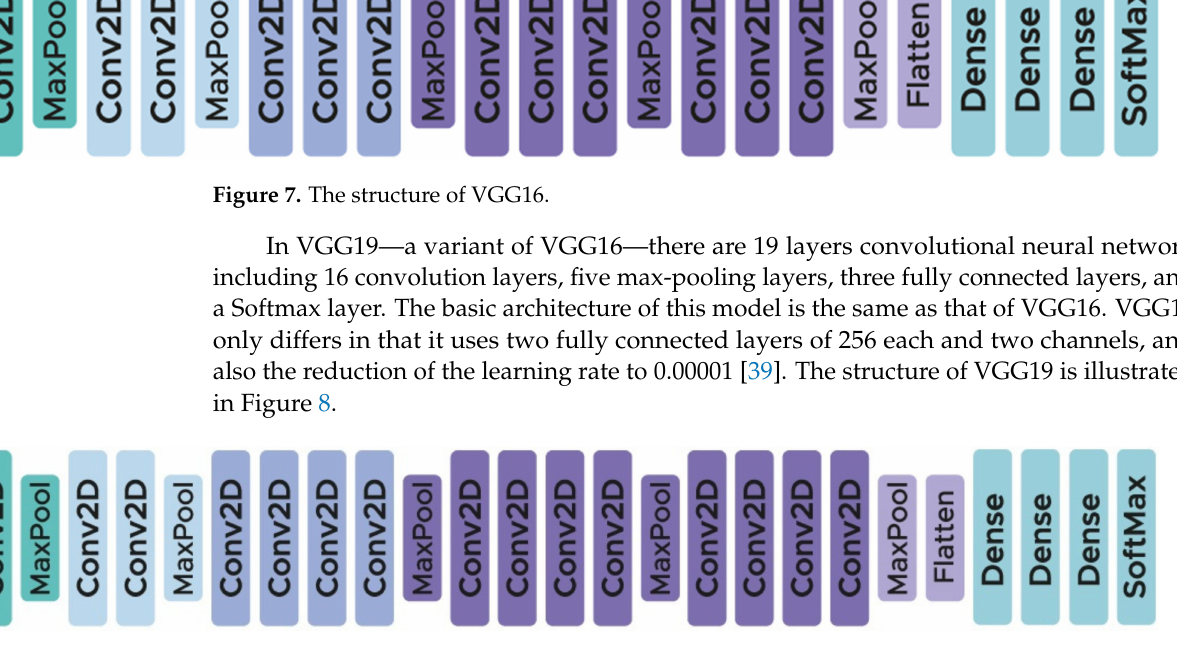
Figure 8. The structure of